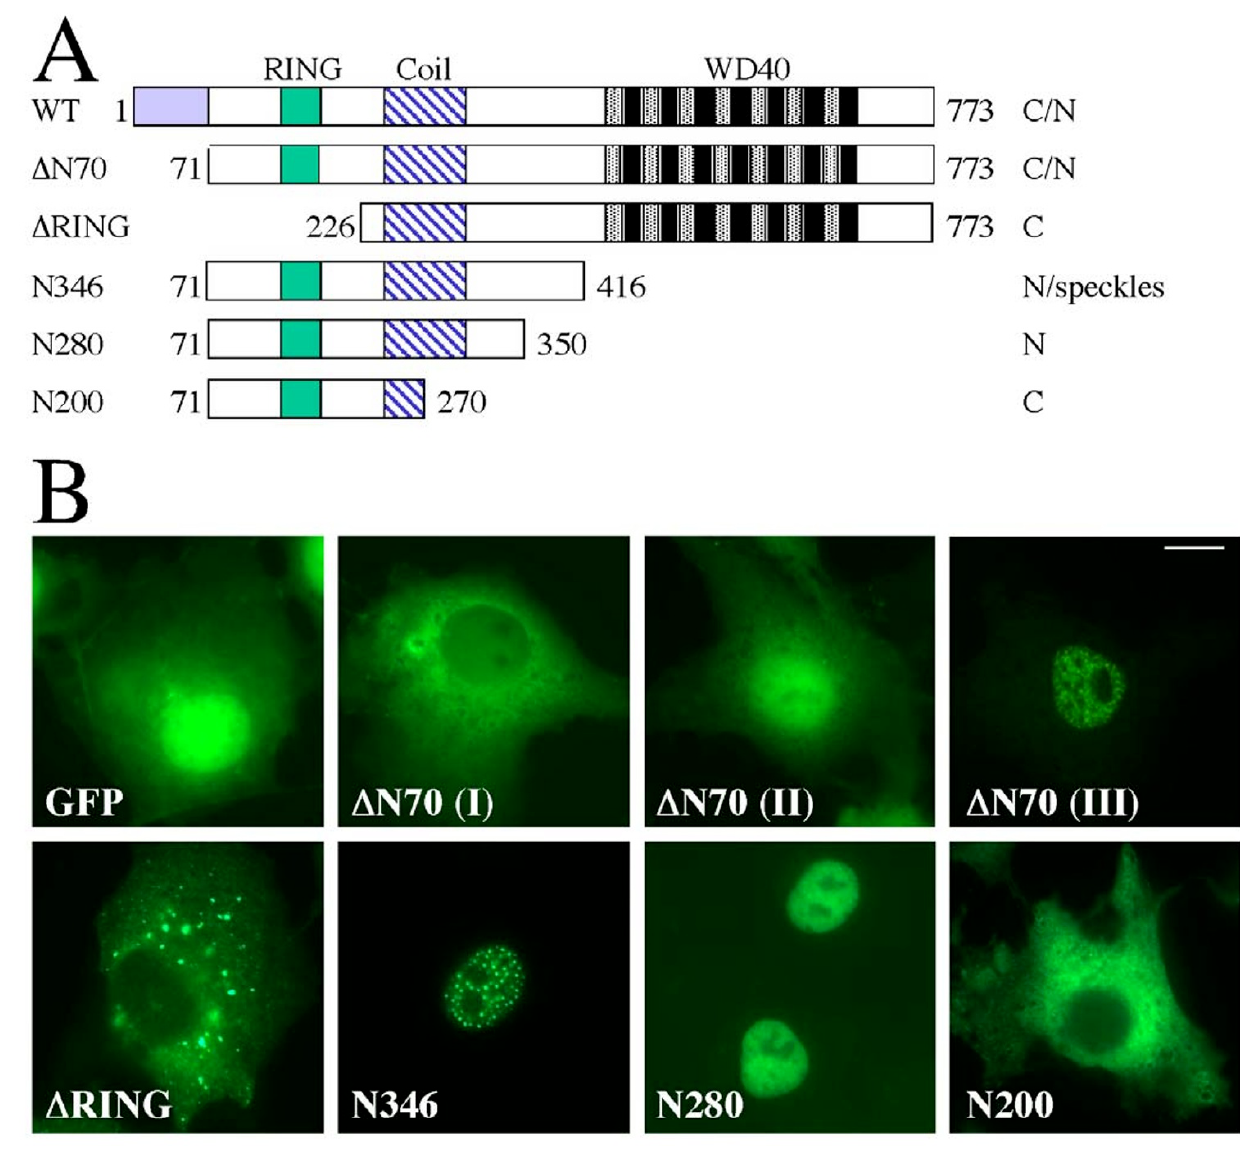
Figure 5 Subcellular localization of MmCOP1 deletion mutant proteins (A) Diagrams of the deletion constructs of MmCOP1 used for the localization studies. ∆ N70, ∆ RING, N346, N280 and N200 are shown in comparison to the full-length MmCOP1 protein (WT), with the locations of the RING-finger (RING), Coiled coil (Coil) and WD40 repeats (WD40) highlighted. The amino acid coordinates at the start and end of each deletion protein version are marked. These sets of COP1 mutants are fused to the C-terminals of GFP or FLAG epitope. The subcellular localization pattern of each protein is indicated on the right. C, cytoplasmic; N, nuclear; C/N, both cytoplasmic and nuclear. (B) GFP fluorescence study of the subcellular localizations of GFP- ∆ N70, GFP- ∆ RING, GFP-N346, GFP-N280 and GFP-N200. ∆ N70 (I-III) are representative of three different localization patterns of cells expressing GFP- ∆ N70. The studies were carried out in COS7 cells. The same magnification was used for all images and the scale bar for 10 micrometer was indicated in the image for ∆ N70